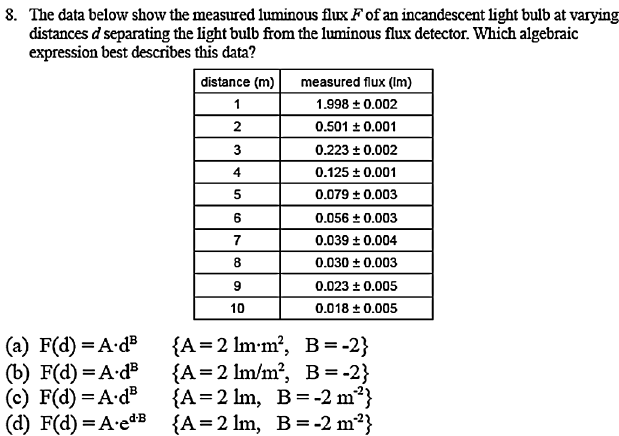
FIG. 10. Item 10 assesses the student’s ability to propagate uncertainty through a simple division, either by knowing the appropriate technique for handling multiple uncertainties or with a judgement that one of the uncertainties is completely dominant. The distractor options include (a) which arises from dividing the uncertainty in the numerator by the measured quantity in the denominator, (b) which arises from dividing the uncertainty in the numerator by the uncertainty in the denominator, (c) which arises from addition of the uncer- tainties, and (e) which arises from multiplication of the uncer-